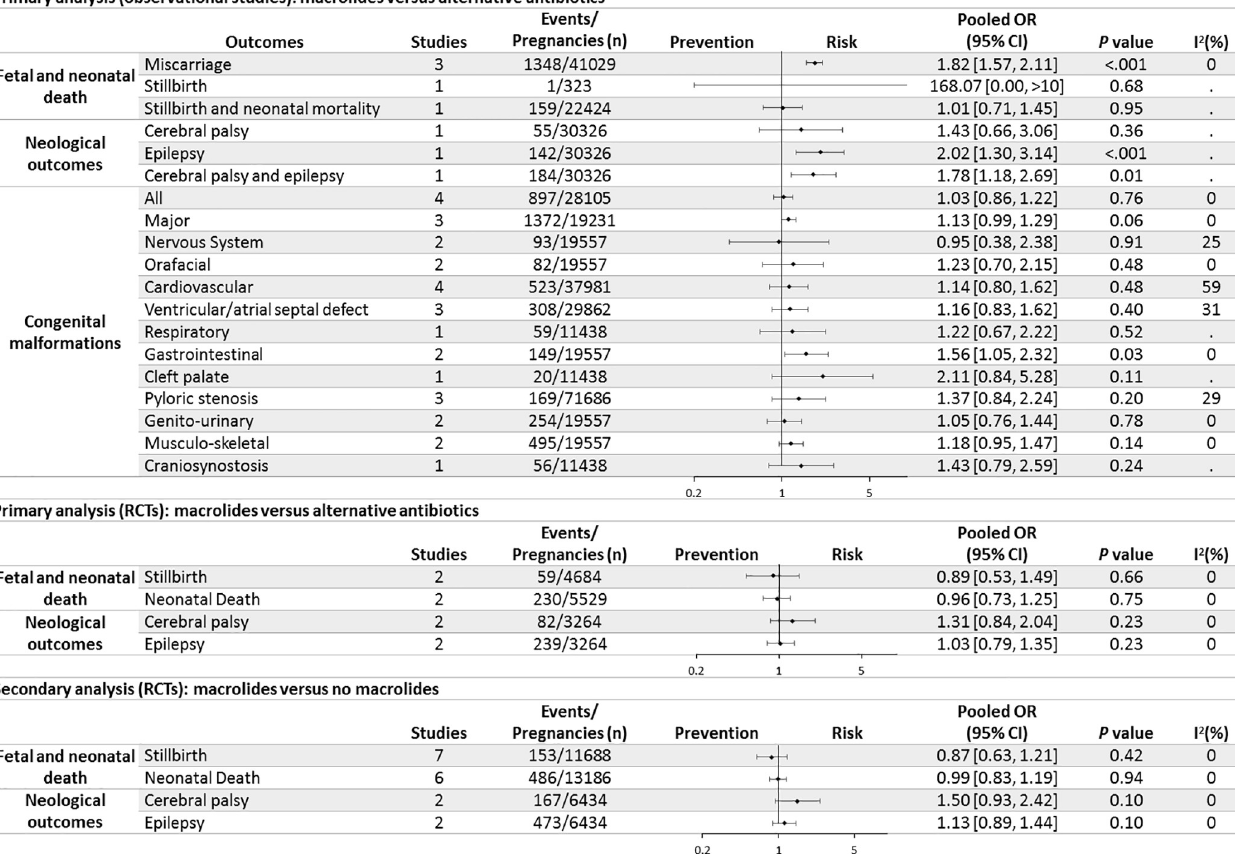
Fig 3. Primary and secondary analysis for the association between prenatal use of macrolides and adverse child outcomes.